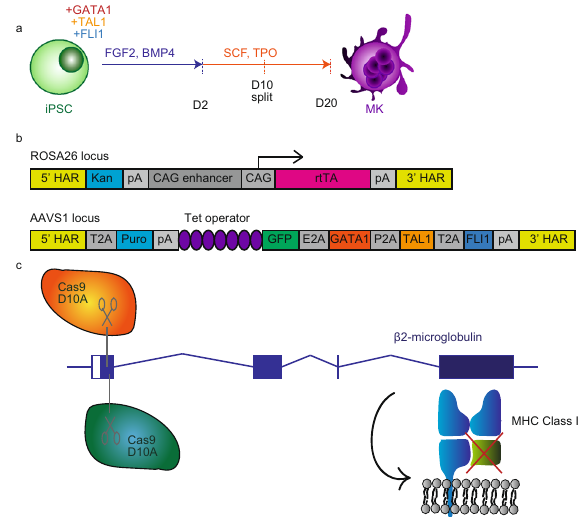
Fig. 1 Generating megakaryocytes from iPSCs. a Overview of the Megakaryocyte Forward Programming protocol. iPSCs overexpres- sing GATA1, TAL1 and FLI1 are differentiated in FGF2 and BMP4 for 3 days and then in SCF and TPO for 17 days to generate mature CD41 + CD42 + megakaryocytes (MKs). b Schematic of the inducible cassette for GATA1, TAL1 and FLI1 expression in iPSCs and their patterning into MKs. One cassette, containing rTTA, is inserted in the ROSA26 locus while a second cassette containing the patterning transcription factors is integrated into the AAVS1 locus. c Schematic of HLA Class I knockout strategy, using paired Cas9 D10A nickases to create a frameshift mutation in β 2